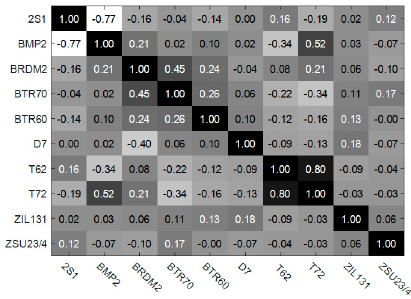
Figure 9. Correlation coefficients of ten different tasks. The term’2S1’means the task to recognize vehicle 2S1 and the meanings of other terms are similar to this one.